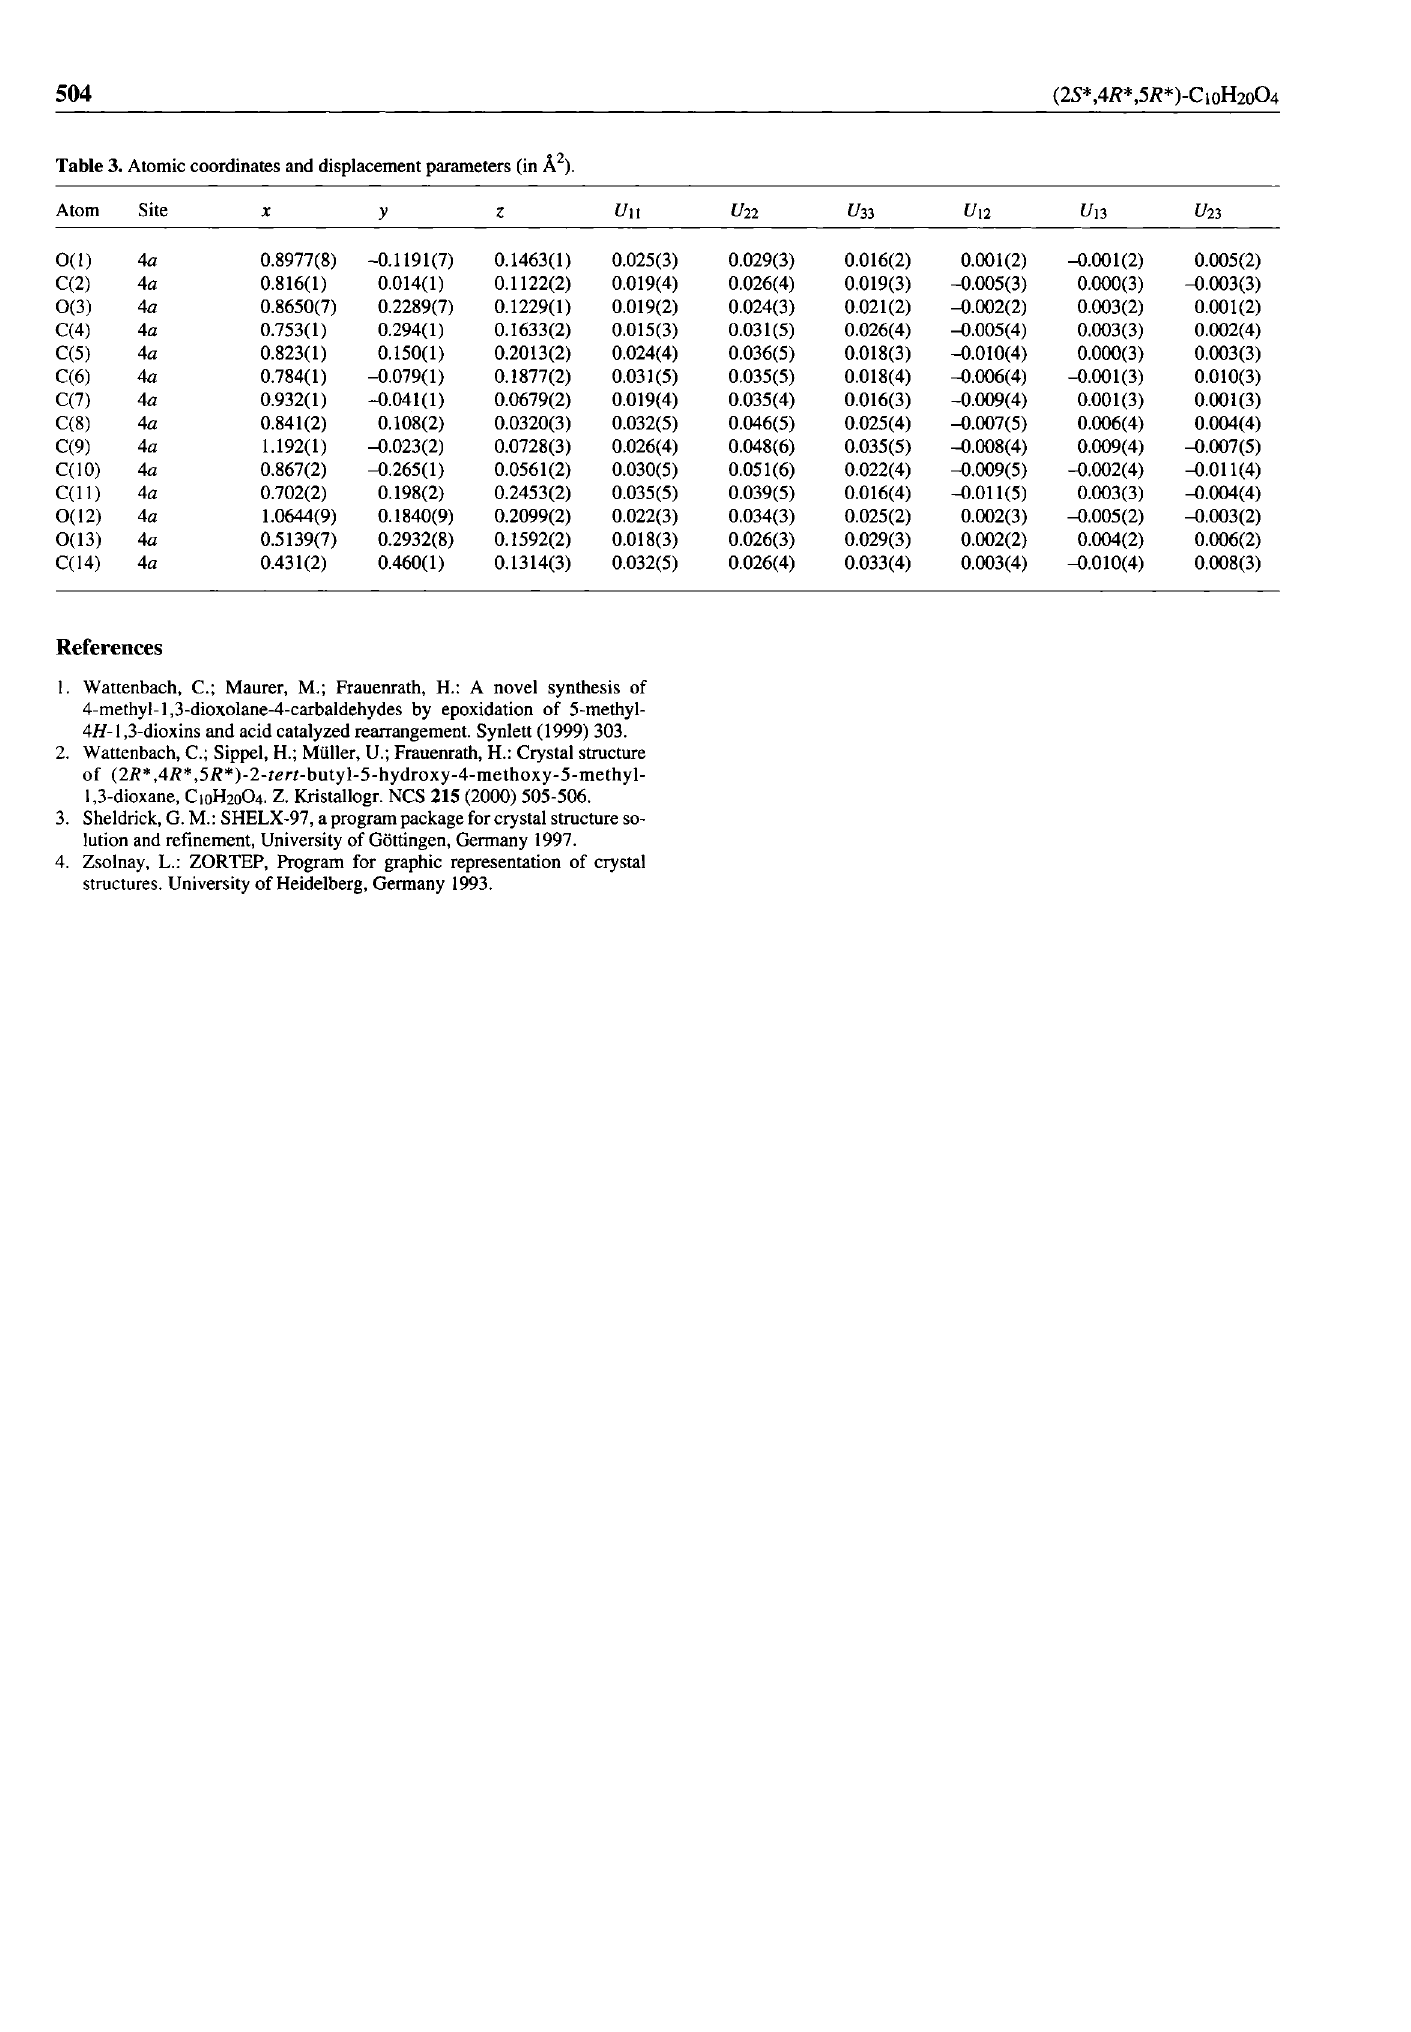
Table 3. Atomic coordinates and displacement parameters (in Â 2